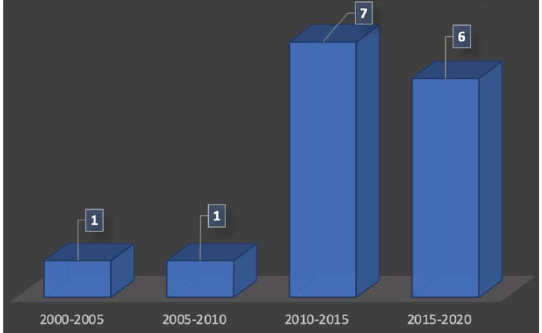
Figure 2. Number of publications over the time.